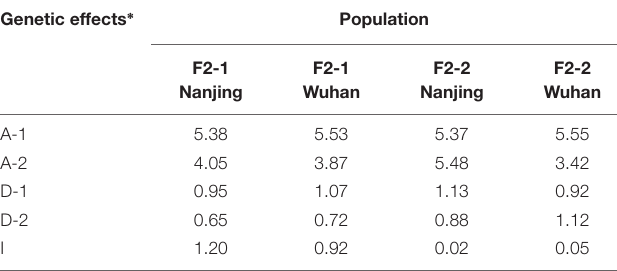
TABLE 3 | Genetic effects of the addition, dominance, and epistasis of these two mutant alleles in F 2